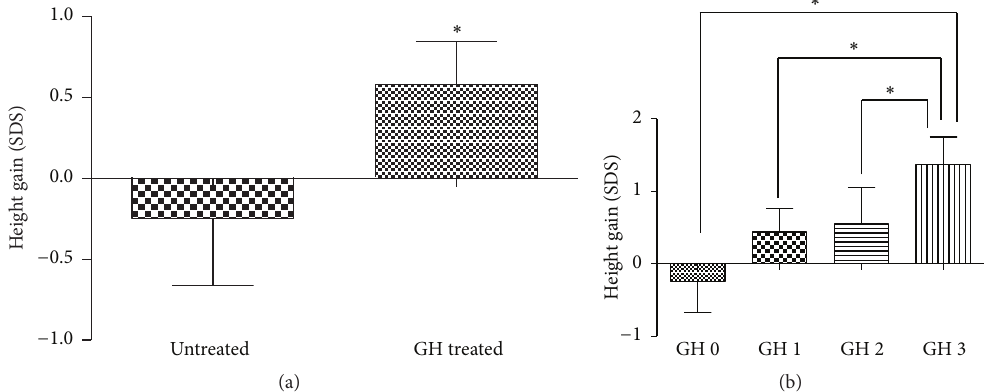
Figure 2: Comparison of height gain. (a) Height gain between the GH treated cohort and untreated cohort. (b) Height gain among different GH therapy duration ∗ 𝑃 < 0.05